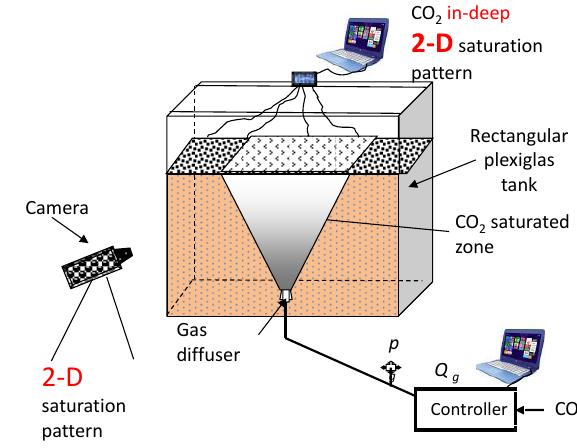
Figure 2. Diagram of the laboratory